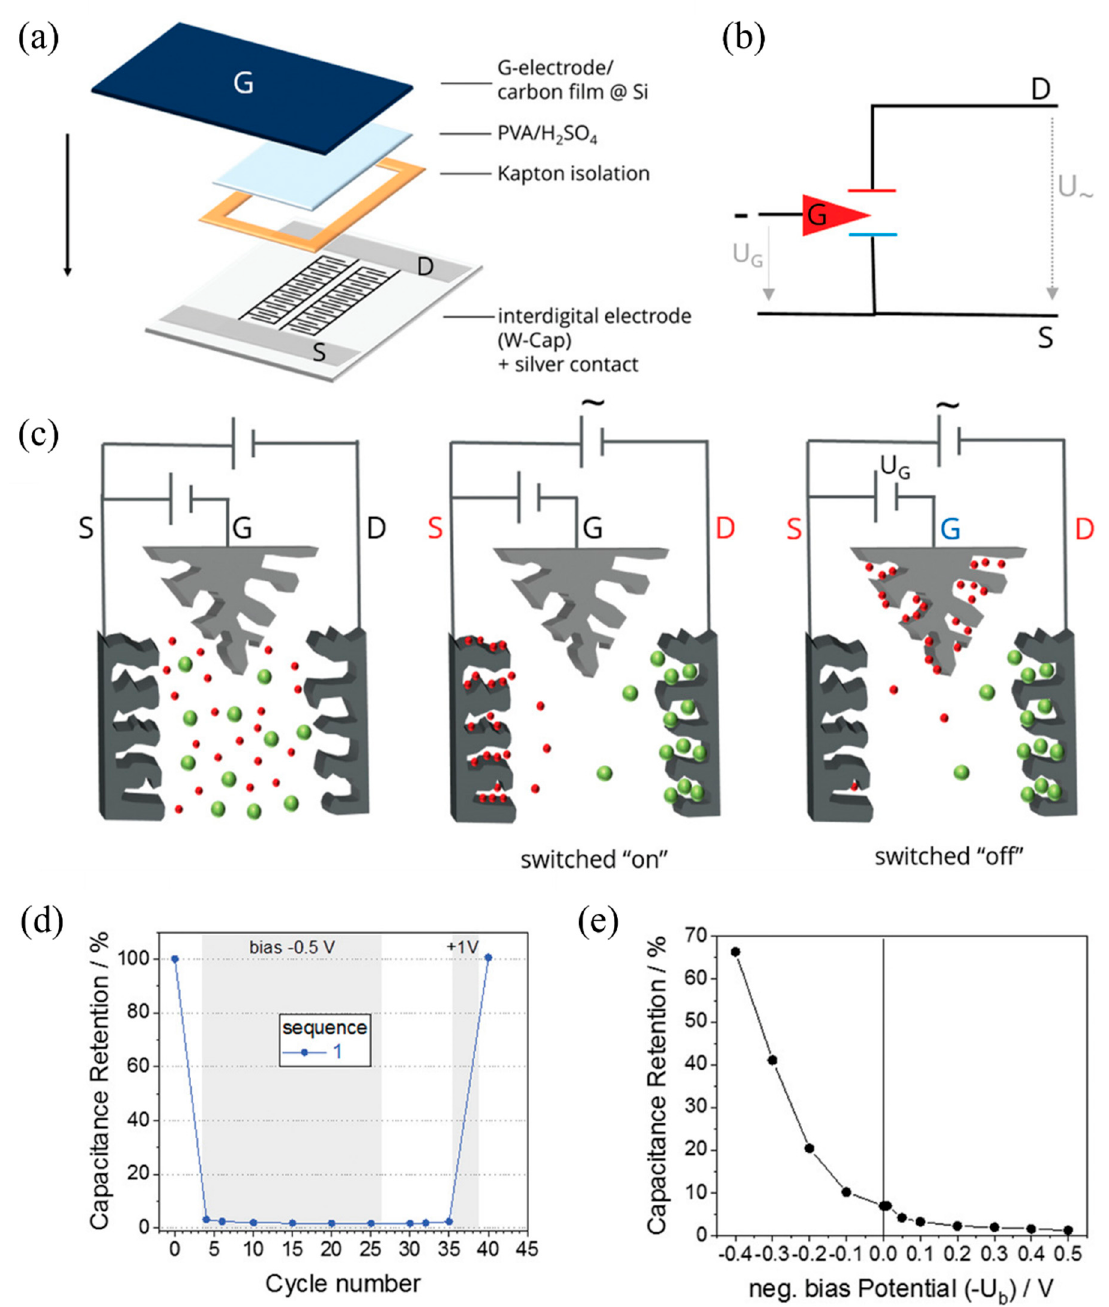
Figure 15. ( a ) Schematic showing the for the switchable microsupercapacitor with a field effect transistor (FET) configuration. ( b ) Electric circuit diagram. ( c ) A schematic illustration of the switching mechanism of the microsupercapacitor. ( d ) A plot of capacitance retention switching measured with 50 mV s − 1 applying a gate voltage of − 0.5 V for the “off” state. ( e ) The capacitance-gating characteristics of the switchable microsupercapacitor. Reprinted with permission from ref. [31] Copyright (2020)